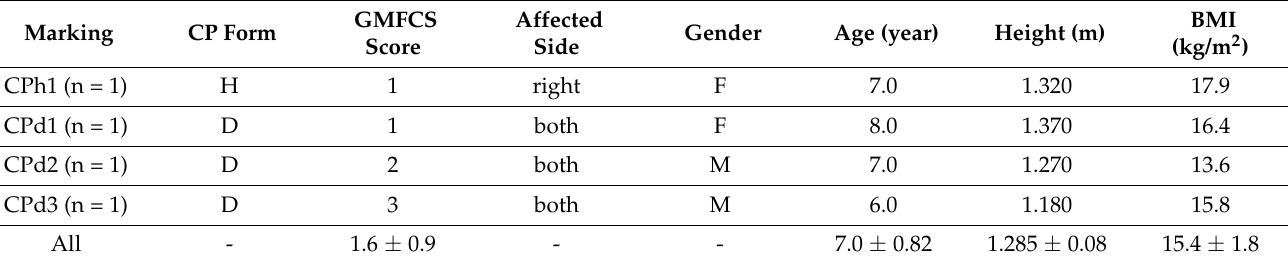
Table 2. Demographic and descriptive data of CP subjects (n =